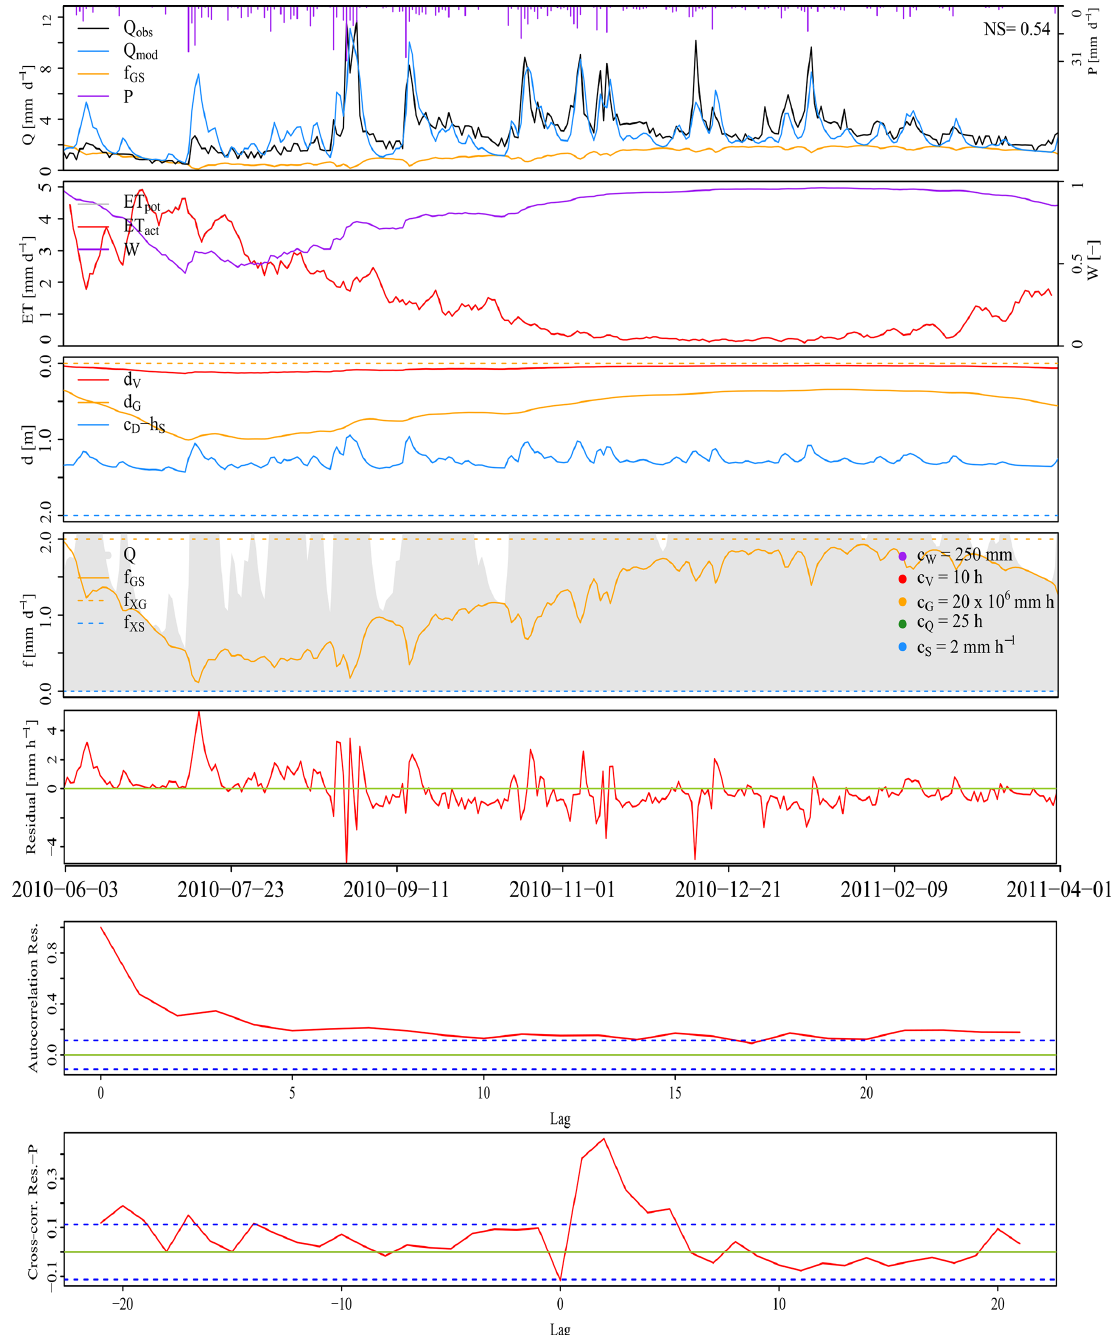
Figure A5. Example of plots enabled by the WALRUS package. This example was generated by using one of the data sets included in the package and simulations with the WALRUS model. From top to bottom: precipitation time series (TS), simulated hydrograph, observed hydrograph and modelled groundwater drainage; potential evapotranspiration TS, modelled actual evapotranspiration TS, wetness index TS; soil reservoir level TS and surface reservoir level TS; seepage TS and surface water supply or extraction TS; flow error (or residuals); autocorrelation of residuals; cross-correlation between residuals and